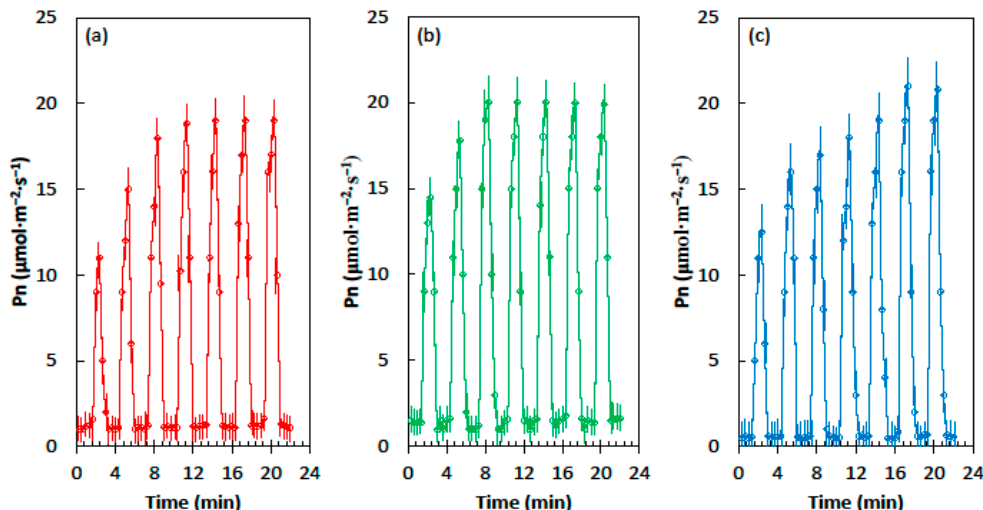
Figure 3. Net CO 2 assimilation (Pn) of the Glycine max leaves in response to the alternating shade flecks with a photosynthetic photon flux density (PPFD) of 55 µ mol · m − 2 · s − 1 and the light flecks with a PPFD of 800 µ mol · m − 2 · s − 1 . The experimental leaves were grown in ( a ) homogeneous 62% sunlight exclusion under a shade screen, ( b ) heterogeneous 62% sunlight exclusion under a slat-house, or ( c ) full sun. Each marker is a mean of four replications.